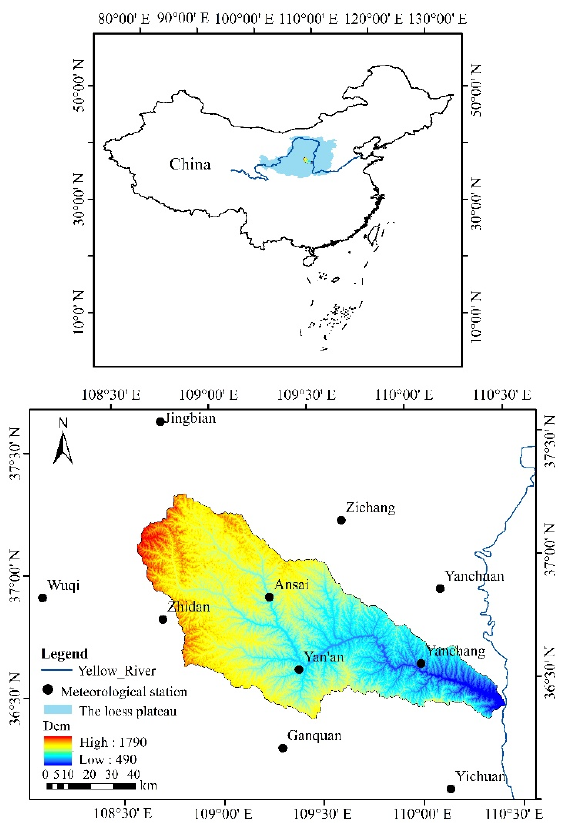
Figure 1. Location of the Yanhe River Basin and the meteorological stations used in this study (black dots).